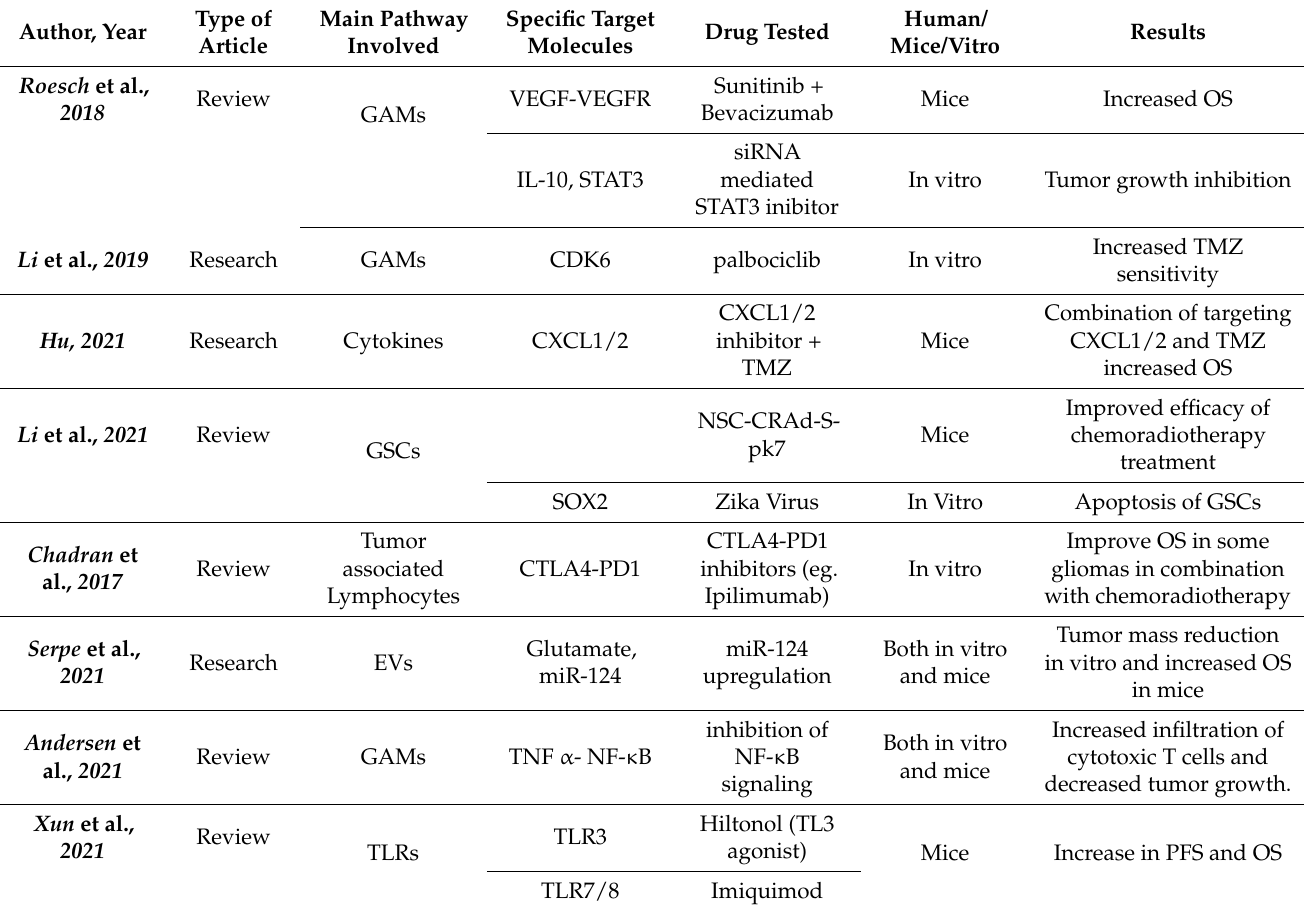
Table 1. Literature synthesis on therapeutic